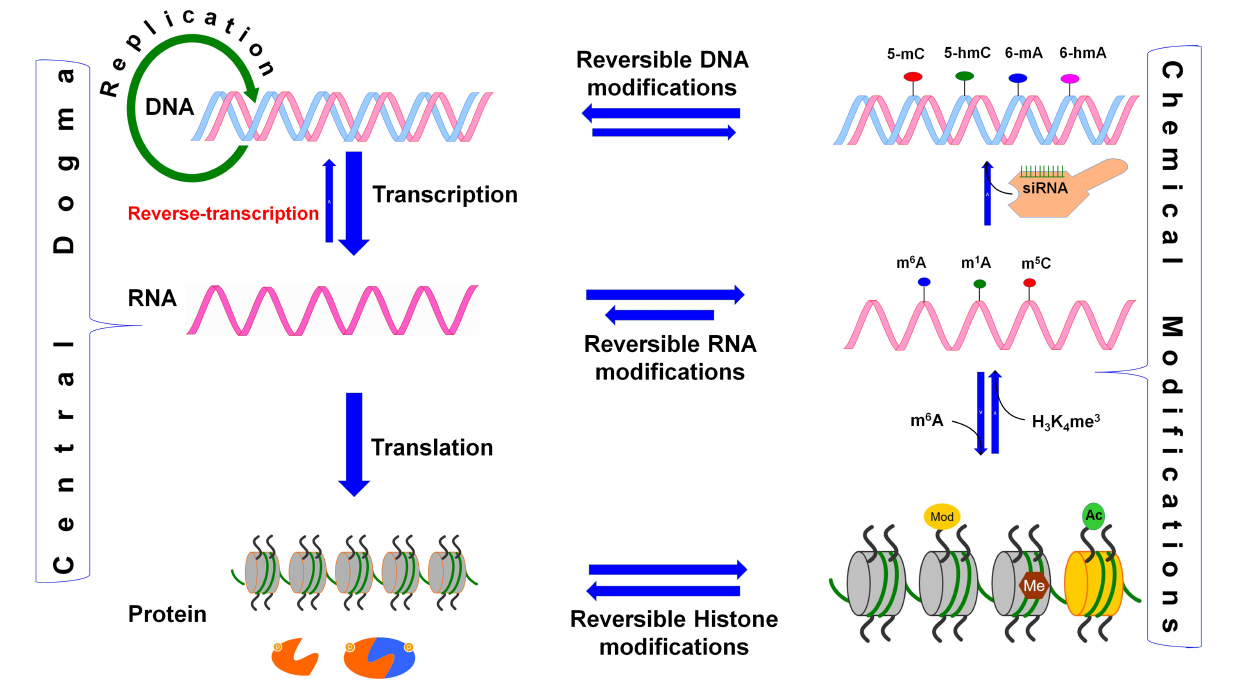
FIGURE 1 | Reversible biochemical modifications affect the transfer of genetic information (the Central Dogma). As per the central dogma, the genetic information passes from DNA, through RNA, to protein. However, epigenetic DNA base modifications [e.g., 5-methylcytosine (5-mC), 5-hydroxymethylcytosine (5-hmC), N 6 -methyladenine (6-mA), and N 6 -hydroxymethyladenine (6-hmA)] and histone protein modifications [e.g., methylation (me) and acetylation (ac) of amino acids] affects RNA metabolism (including splicing, export, stability, and translation efficiency) and play crucial roles in the regulation of cellular growth, development, and protection from environmental stress. Similarly, the dynamic RNA modifications [e.g., N 6 -methyladenosine (m 6 A), N 1 -methyladenosine (m 1 A), and N 6 -hydroxymethyladenosine (hm 6 A)] encrypt an additional layer of information and dynamically regulate the biological processes. Small-interfering RNA (siRNA) plays important role in recruitment of DNA methyltranferase for DNA base modification, methylated mRNA bases (e.g., m 6 A) play role in protein synthesis, the histone 3 (H 3 ) protein trimethylated (me 3 ) at 4th lysine of (H 3 K 4 me 3 ) affects the transcription